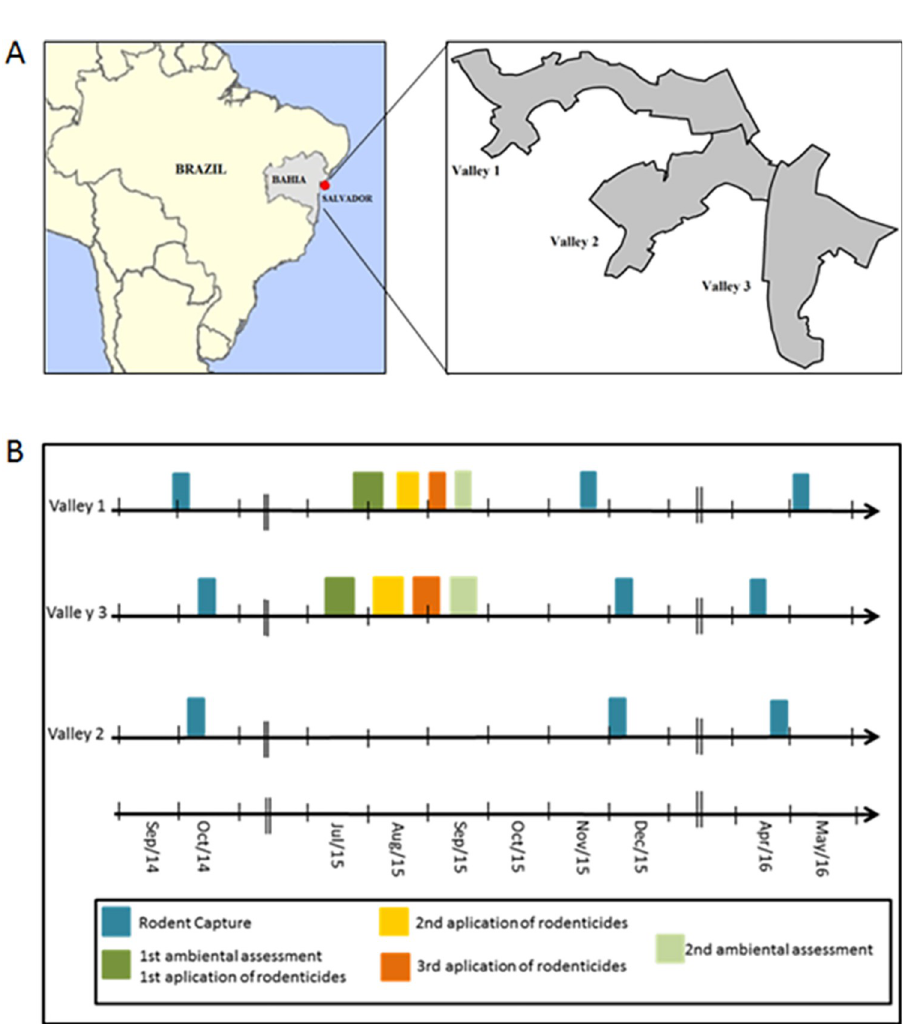
Fig 1. A. Study area in Brazil. B . Schedule of events in Pau da Lima, Salvador, Brazil. Capture, environmental assessment, chemical intervention stratified by valley during the study